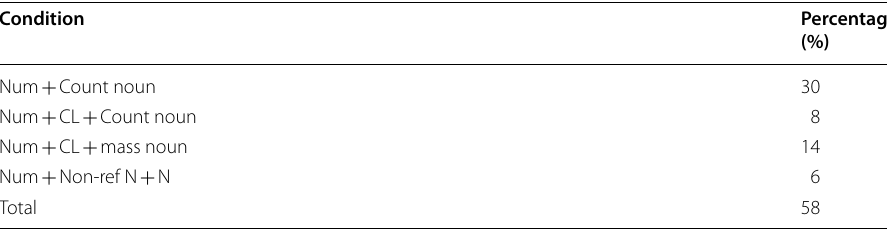
Table 1 The overall accuracy per condition Condition